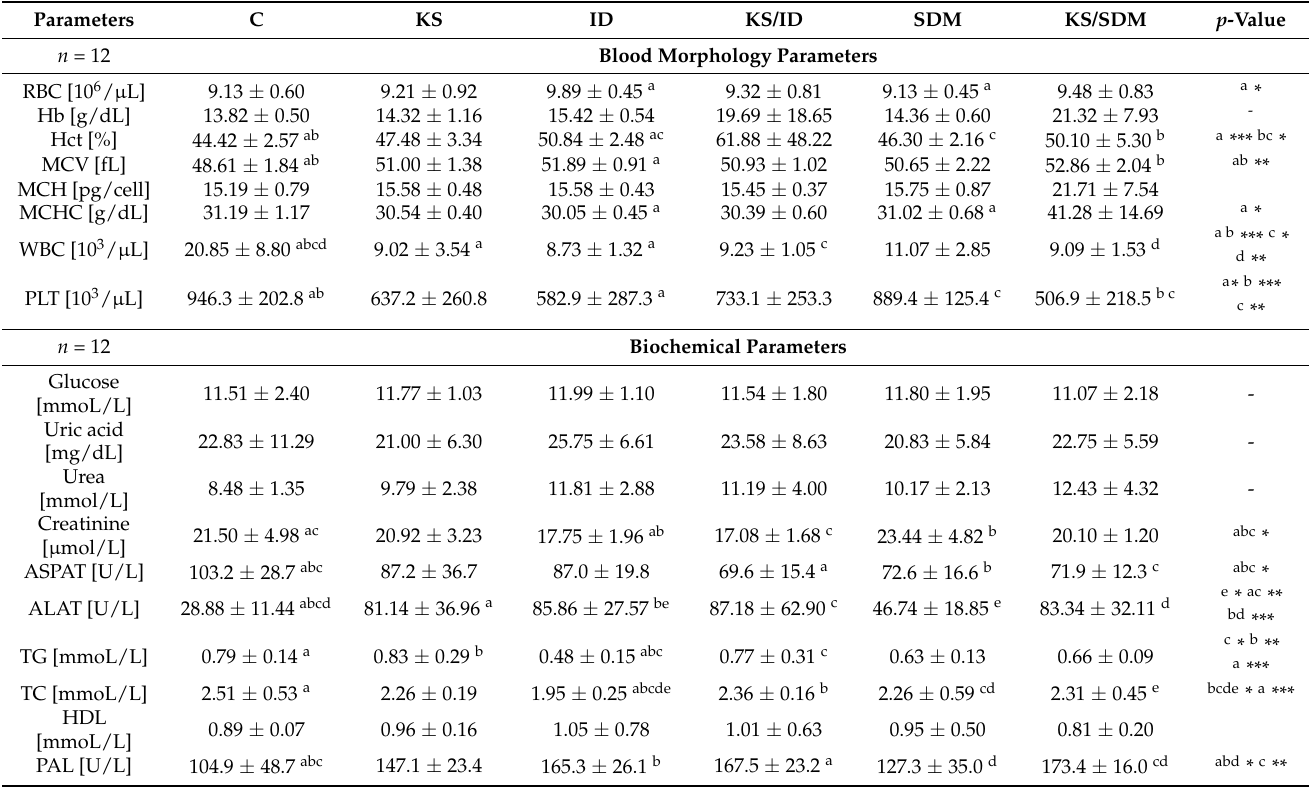
Table 4. The blood morphology and biochemical parameters of rats (see Section 2. for the explanation of the groups’ acronyms and all